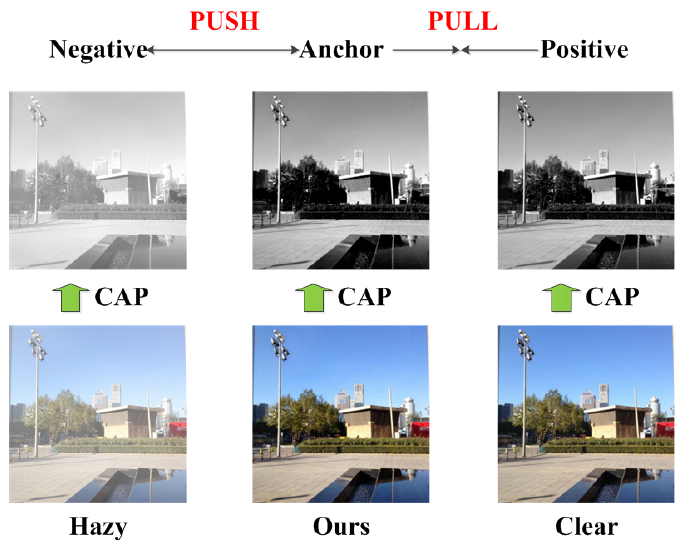
Figure 8. The diagram of contrastive learning. “CAP” denotes the process of obtaining concentration of haze based on color attenuation